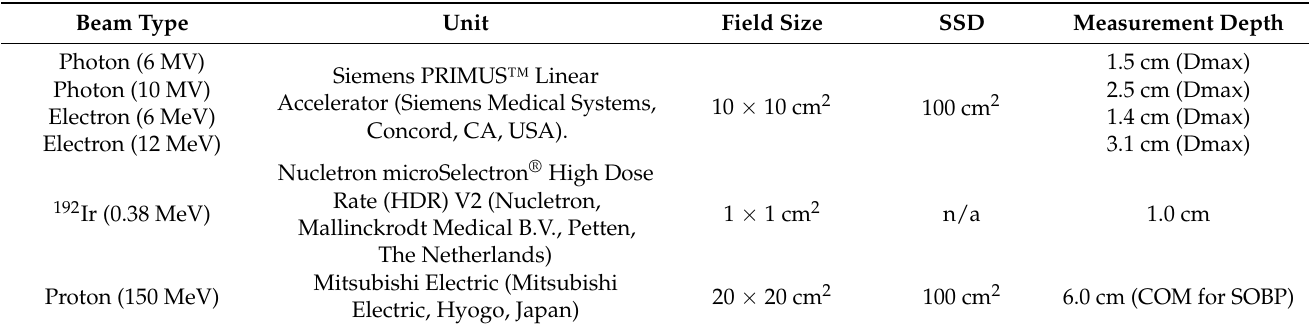
Table 3. Overview description of film irradiation setups.